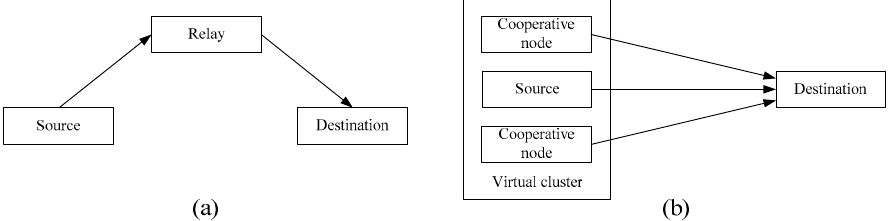
Figure 3. Cooperative transmission: ( a ) relay mode and ( b ) co-transmission mode.